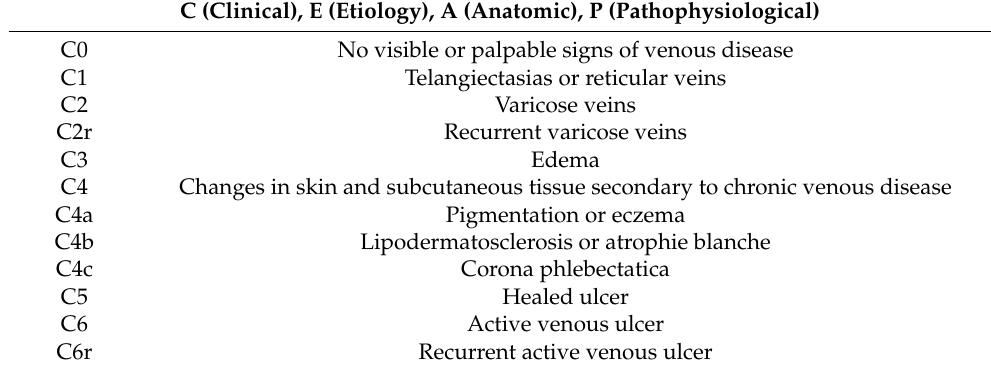
Table 1. CEAP Classification System.